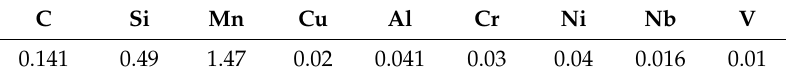
Table 3. Chemical composition of DP1000 steel [wt.%] [24].